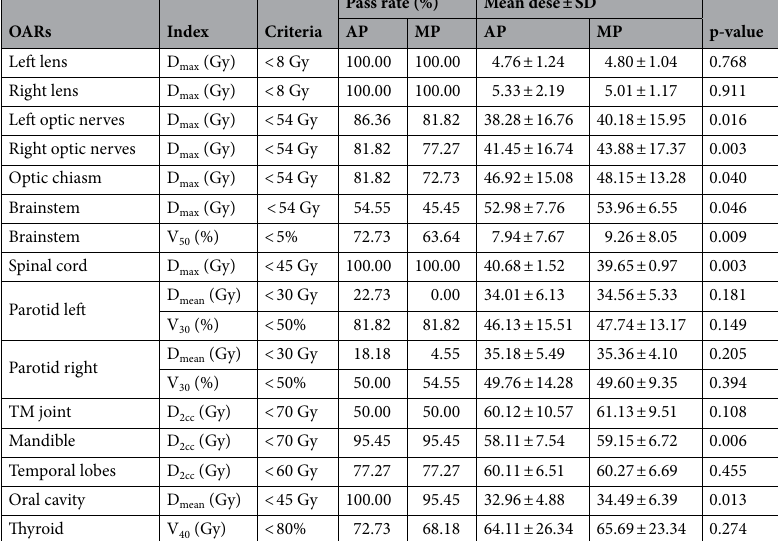
Table 5. Dosimetric comparison of OARs in manual and automatic VMAT (mean ± SD).